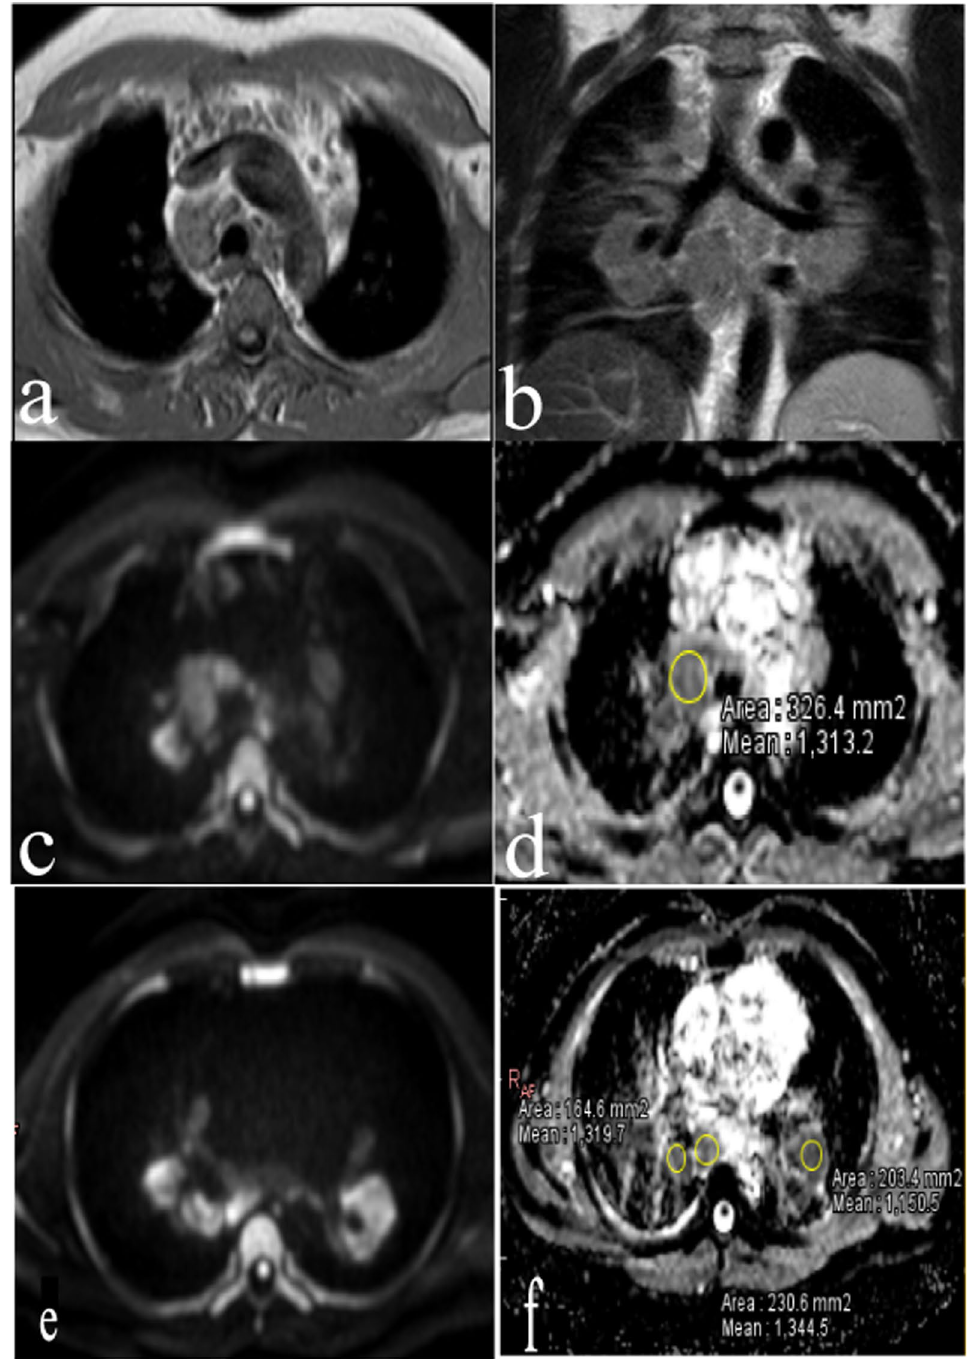
Fig. 5 a Coronal T2WI, b axial T1WI, c , e diffusion-weighted MRI image, d , f ADC map showing right paratracheal, bilateral hilar, subcarinal and posterior mediastinal lymph nodes which display isointense signal on T1 and hyperintense on T2 WI. They appear faintly hyperintense on DWI with dark signal in ADC map. The mean ADC value is 1.28 10 − 3 mm 2 ×